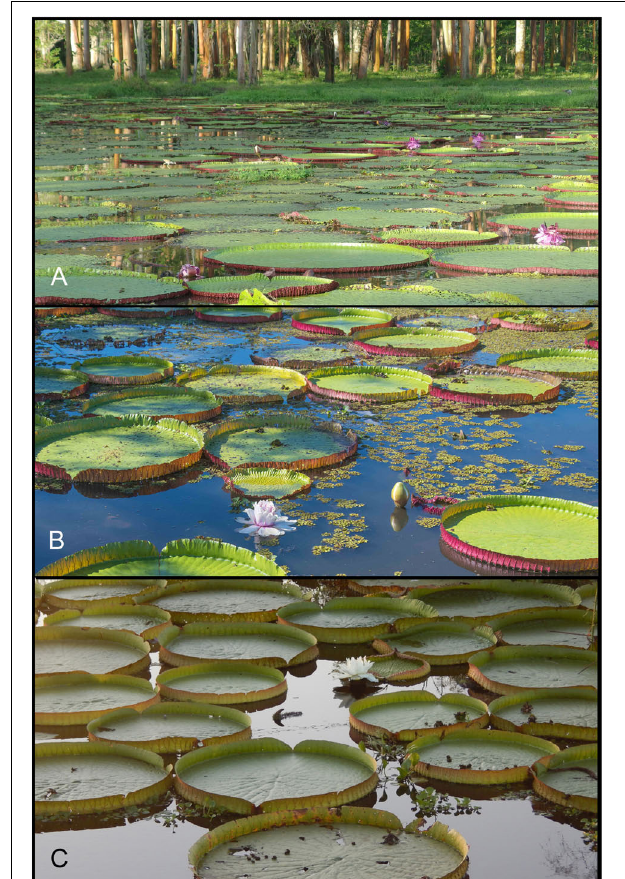
FIGURE 1 | Wild populations of (A) Victoria amazonica (Peru, Loreto), (B) V. boliviana sp. nov. (Bolivia, Beni) and (C) V. cruziana (Argentina, Chaco). (Photo Credits: (A) Laurel Allen, iNaturalist ID 821386. (B) Carlos Magdalena. (C) Fernanda Alarcón, iNaturalist ID.